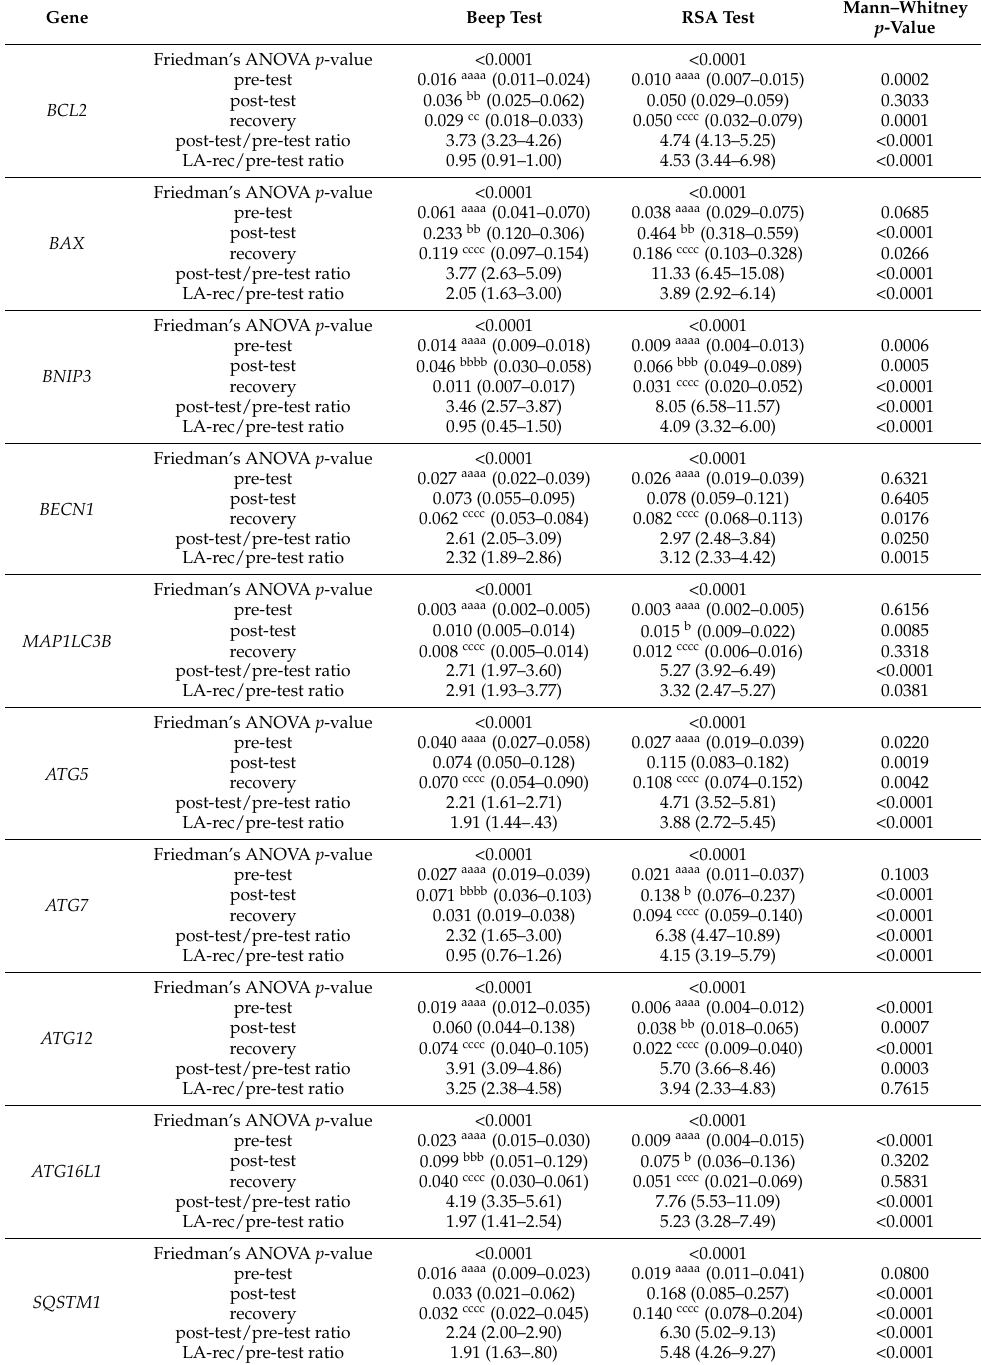
Table 6. The expression (2 − ∆ Ct values) of death-related genes of studied participants’ blood